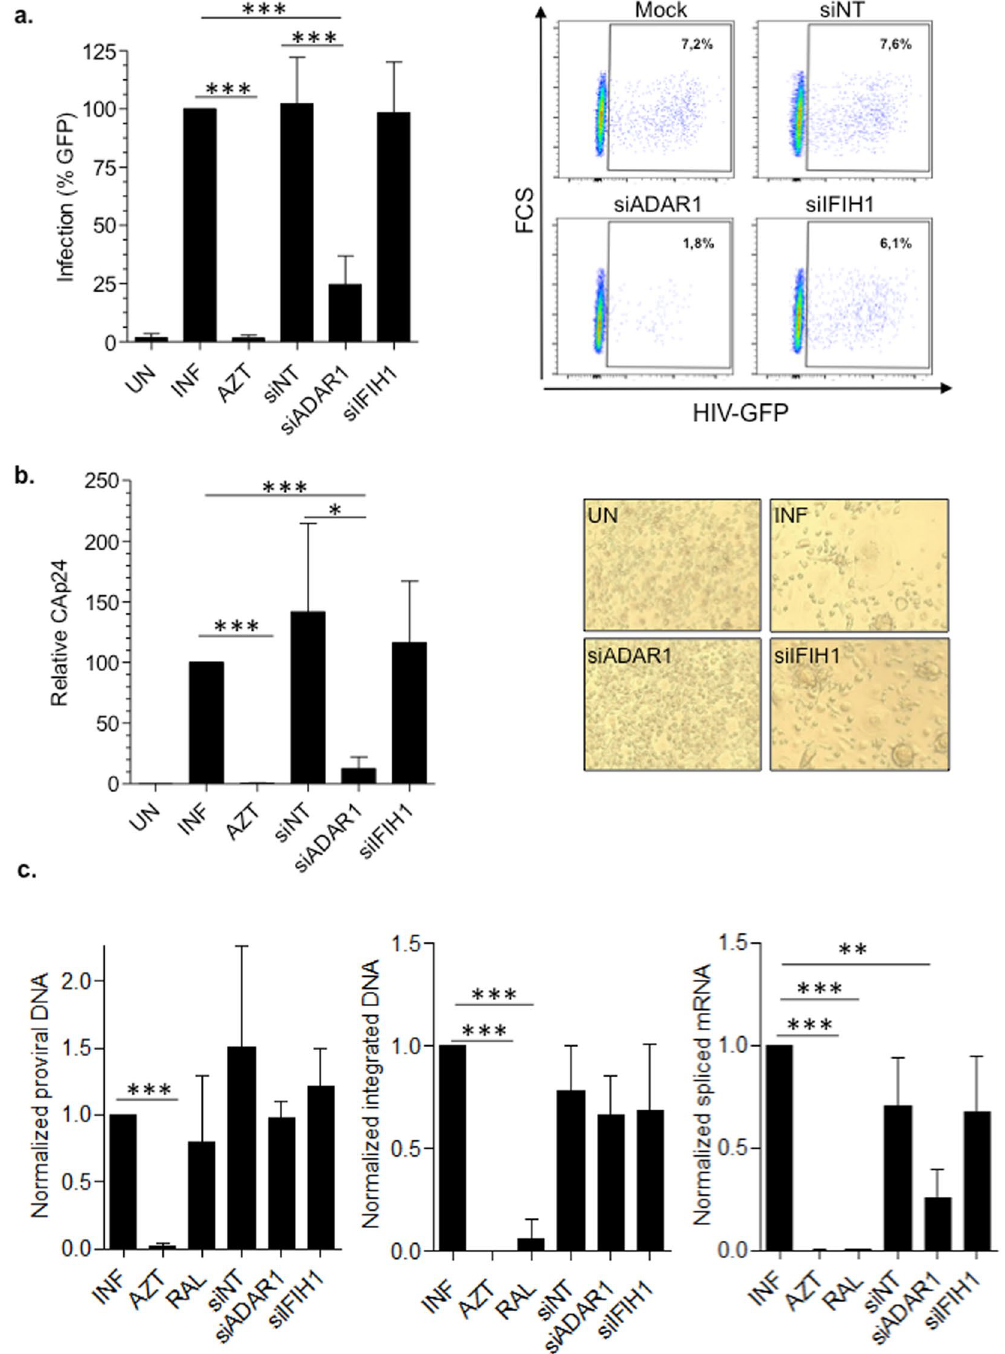
Figure 2. ADAR1 knockdown blocks HIV-1 transcription in primary macrophages. ( a ) HIV-1 replication in ADAR1 and IFIH1 knockdown M-CSF macrophages, infected with a VSV-pseudotyped, GFP-expressing HIV- 1. Infection was measured 72 h later by flow cytometry. Data represent percentage replication relative to mock- transfected macrophages (left panel). A representative flow cytometry dot plot showing infected macrophages is also depicted (right panel). Mean ± SD of at least 5 different donors performed in triplicate is shown. (b) HIV-1 replication in ADAR1 and IFIH1 knockdown M-CSF macrophages, infected with a full replicative HIV-1 BaL strain. Differentiated macrophages were infected for 7 days and CAp24 production was measured in culture supernatant by ELISA. Mean ± SD of 3 different donors performed in triplicate is shown. (c) Proviral DNA formation (left panel), viral integration (middle panel) and viral transcription (right panel) in ADAR1 and IFIH1 knockdown macrophages. siRNA-treated and subsequently differentiated macrophages were infected with HIV-1 BaL for 16 h (for proviral DNA formation), 20 h (for viral DNA integration) or 40 h (for viral transcription) before DNA or RNA extraction. All determinations were normalized to mock-treated infected macrophages and AZT (3 µ M) or raltegravir (RAL; 2 µ M), were included as controls. Mean ± SD of at least